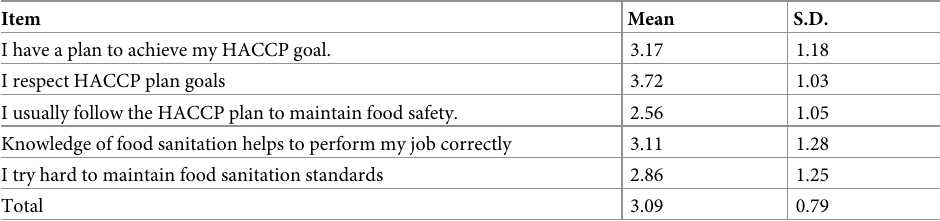
Table 4. HACCP Practice for the